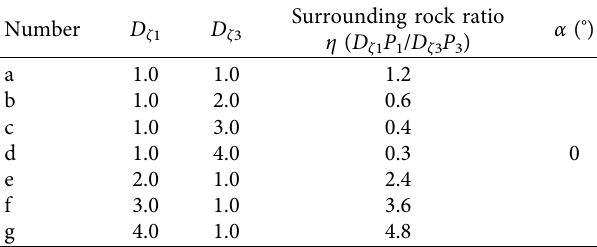
Table 2: Simulation plan with different mining coefficients. Number D ζ 1 D ζ 3